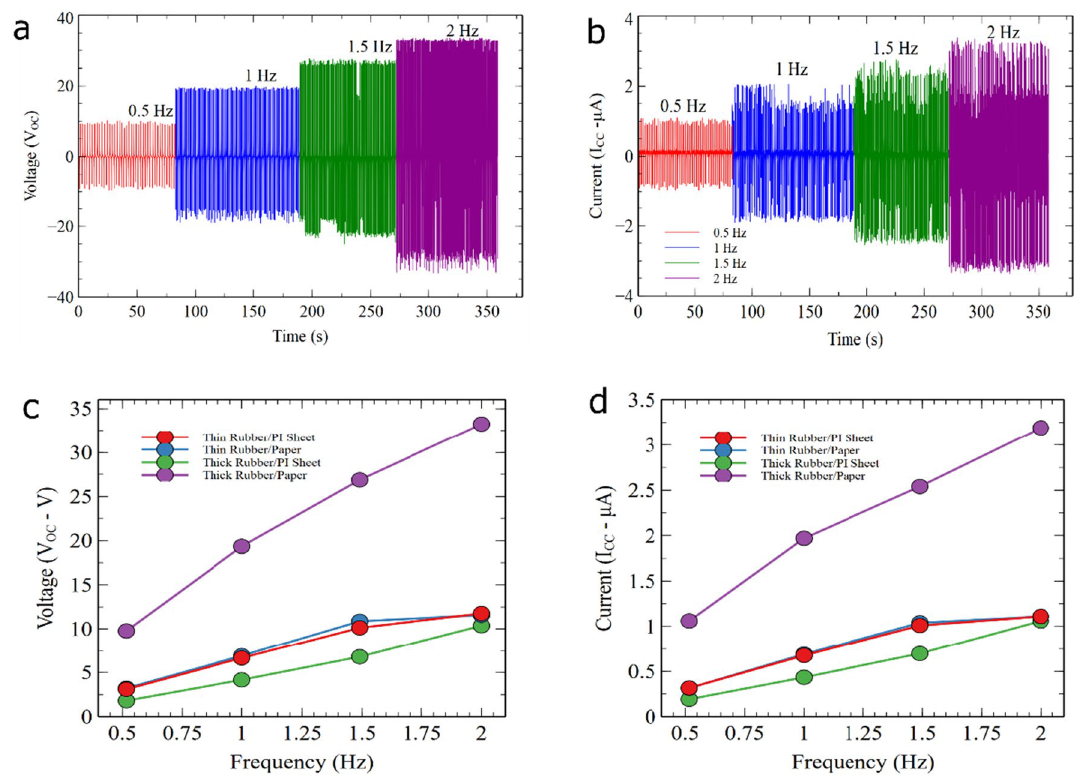
Fig. 2 a Open-circuit voltage ( V OC ) and b short circuit current ( I SC ) during operation of R-TENG with thick rubber and PVDF-coated paper as contact surfaces at different frequencies. c V OC and d I SC for various R-TENGs as a function of operational